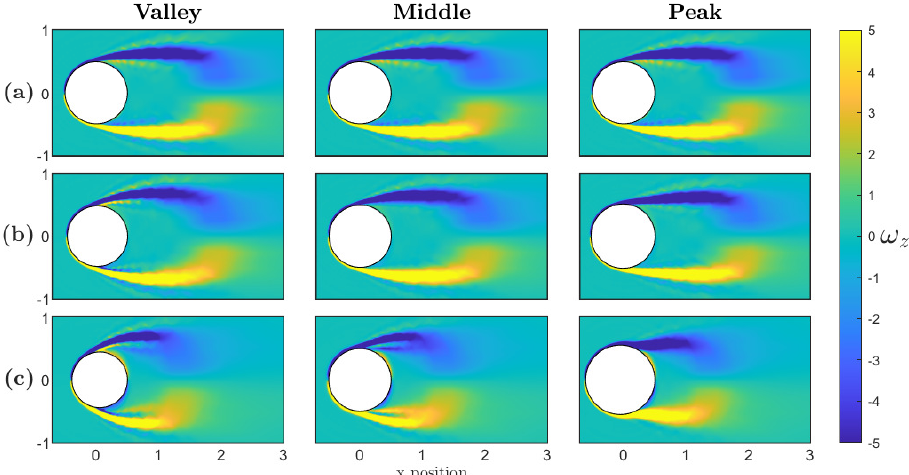
Figure 11. Two − dimensional contours of mean spanwise vorticity ω z for the three relevant sections (see the header on top) of the simulated cylinders: baseline ( a ), A03 ( b ), and A11 ( c ). The baseline model plots are repeated on the top